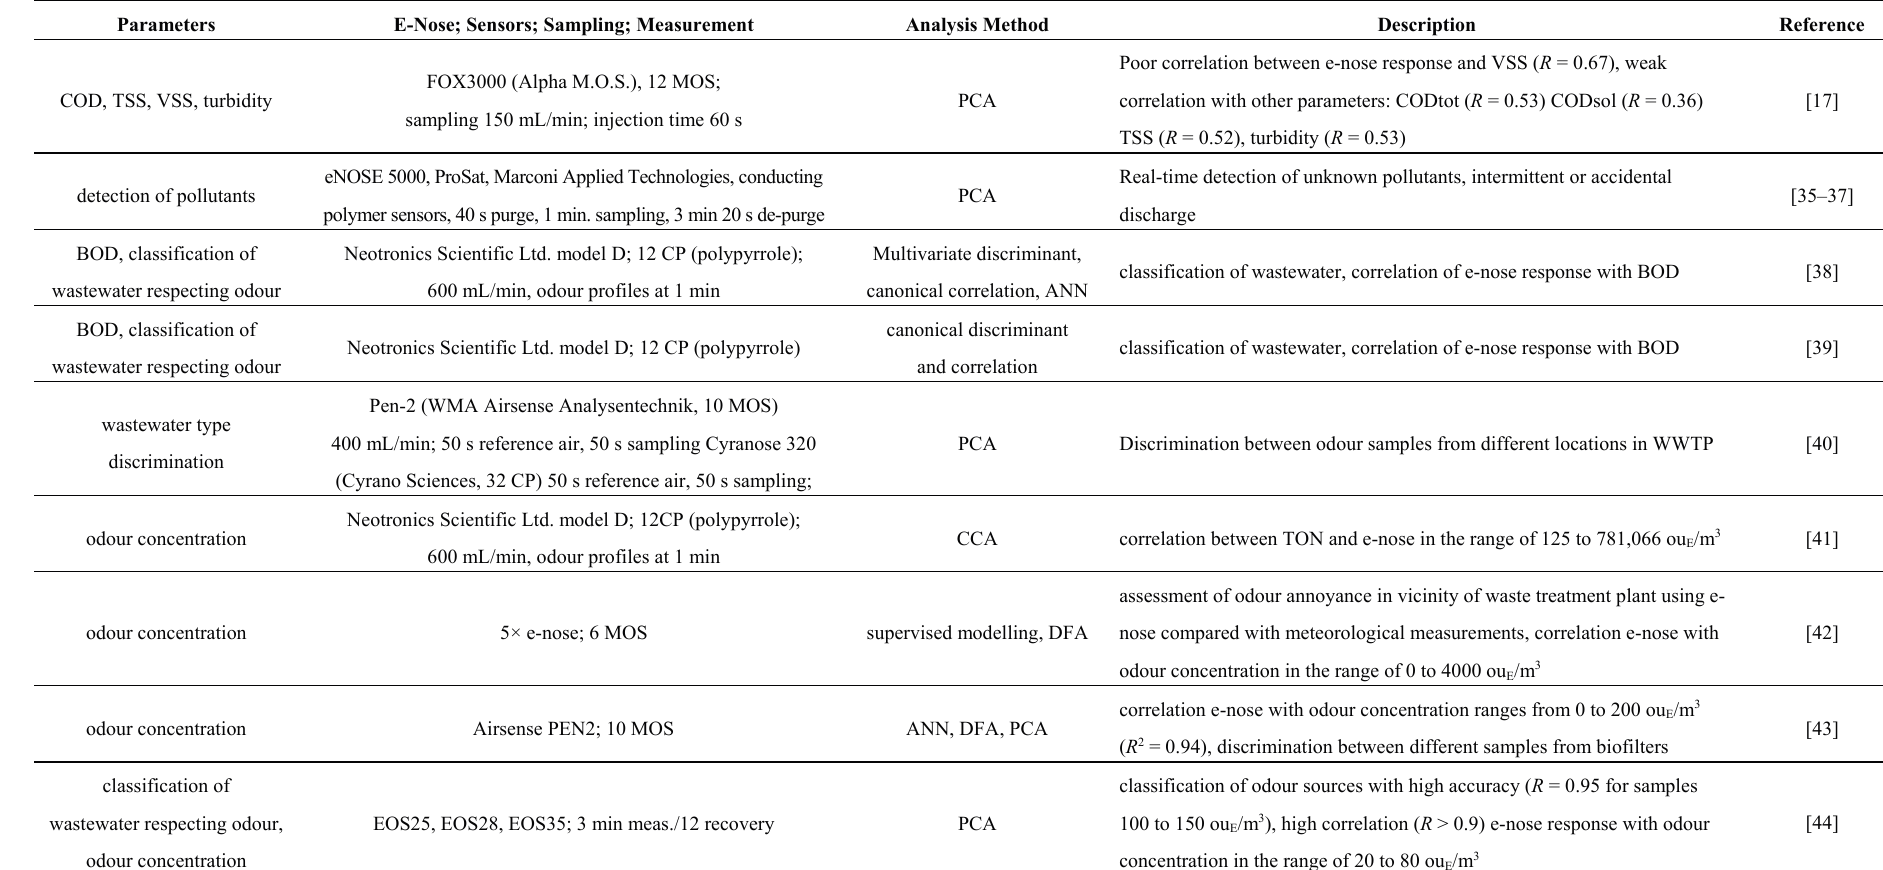
Table 2. Application of e-nose for evaluation of wastewater